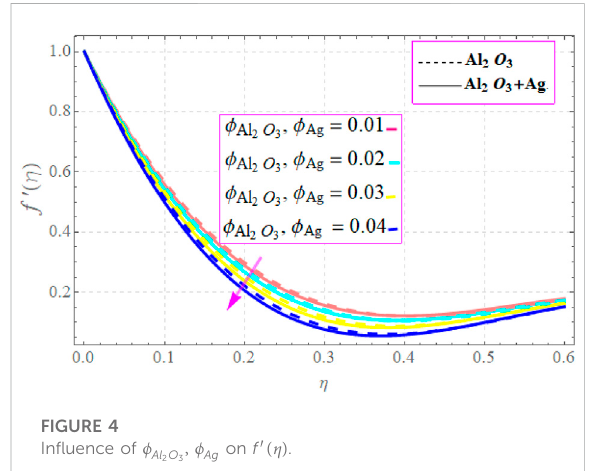
, ϕ Ag on f ′ ( η ) . 2 O 3